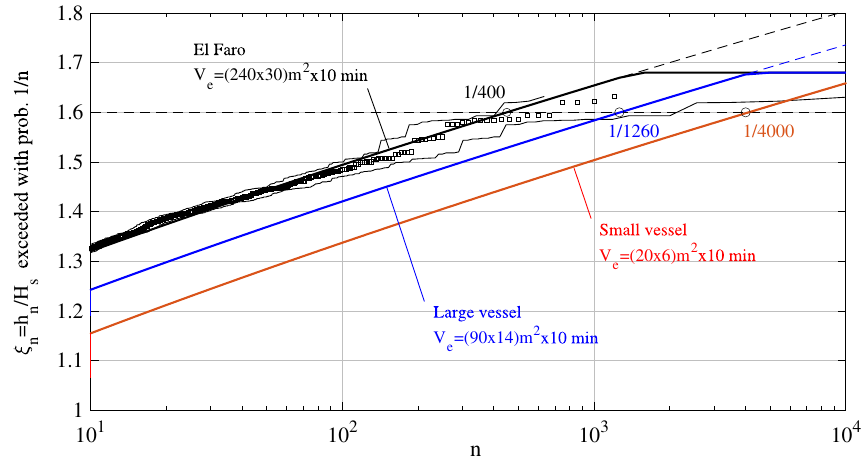
1.68 ) for the maximum = LW m 2 x D min spanned =